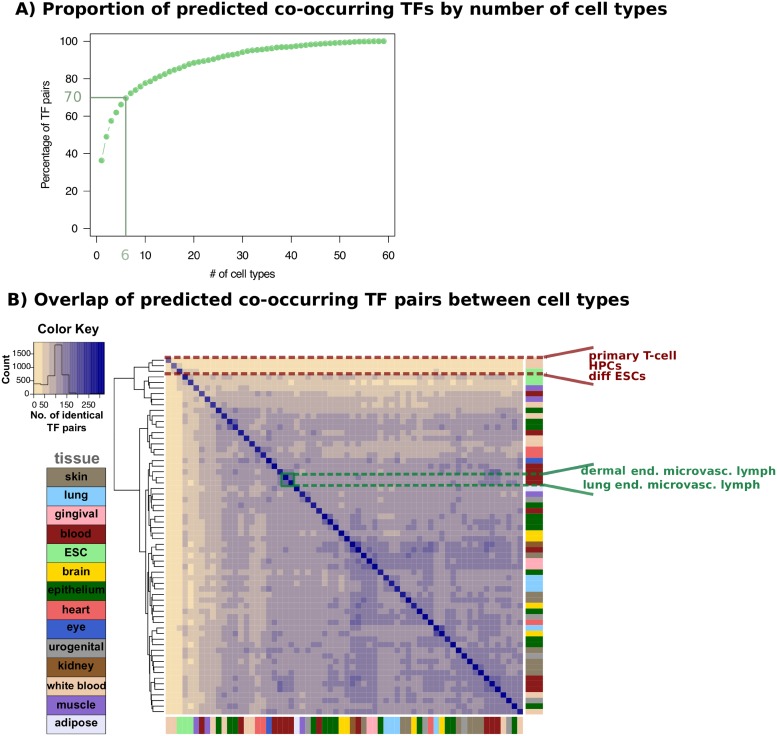
Cell-type specificity of predicted co-occurring TF pairs by CoTRaCTE.A) Cumulative plot of number of cell types in which TF pairs are predicted to co-occur. As highlighted with the green lines, 70% of all predicted co-occurring TF pairs are highly cell-type specific i.e. they are observed in only 6 cell types or fewer. B) Heatmap of overlapping predicted co-occurring TF pairs over 64 cell types. Each cell depicts the number of TF pairs shared between the corresponding pair of cell types. Primary T-cell, HPCs and ESCs (highlighted with red dashed lines) possess sets of co-occurring TF pairs which are distinct from those of other cell types. Functionally related cell types such as microvascular endothelial dermal lymph cells and microvascular endothelial lung lymph cells (highlighted with green dashed lines) share a large number of TF pairs.